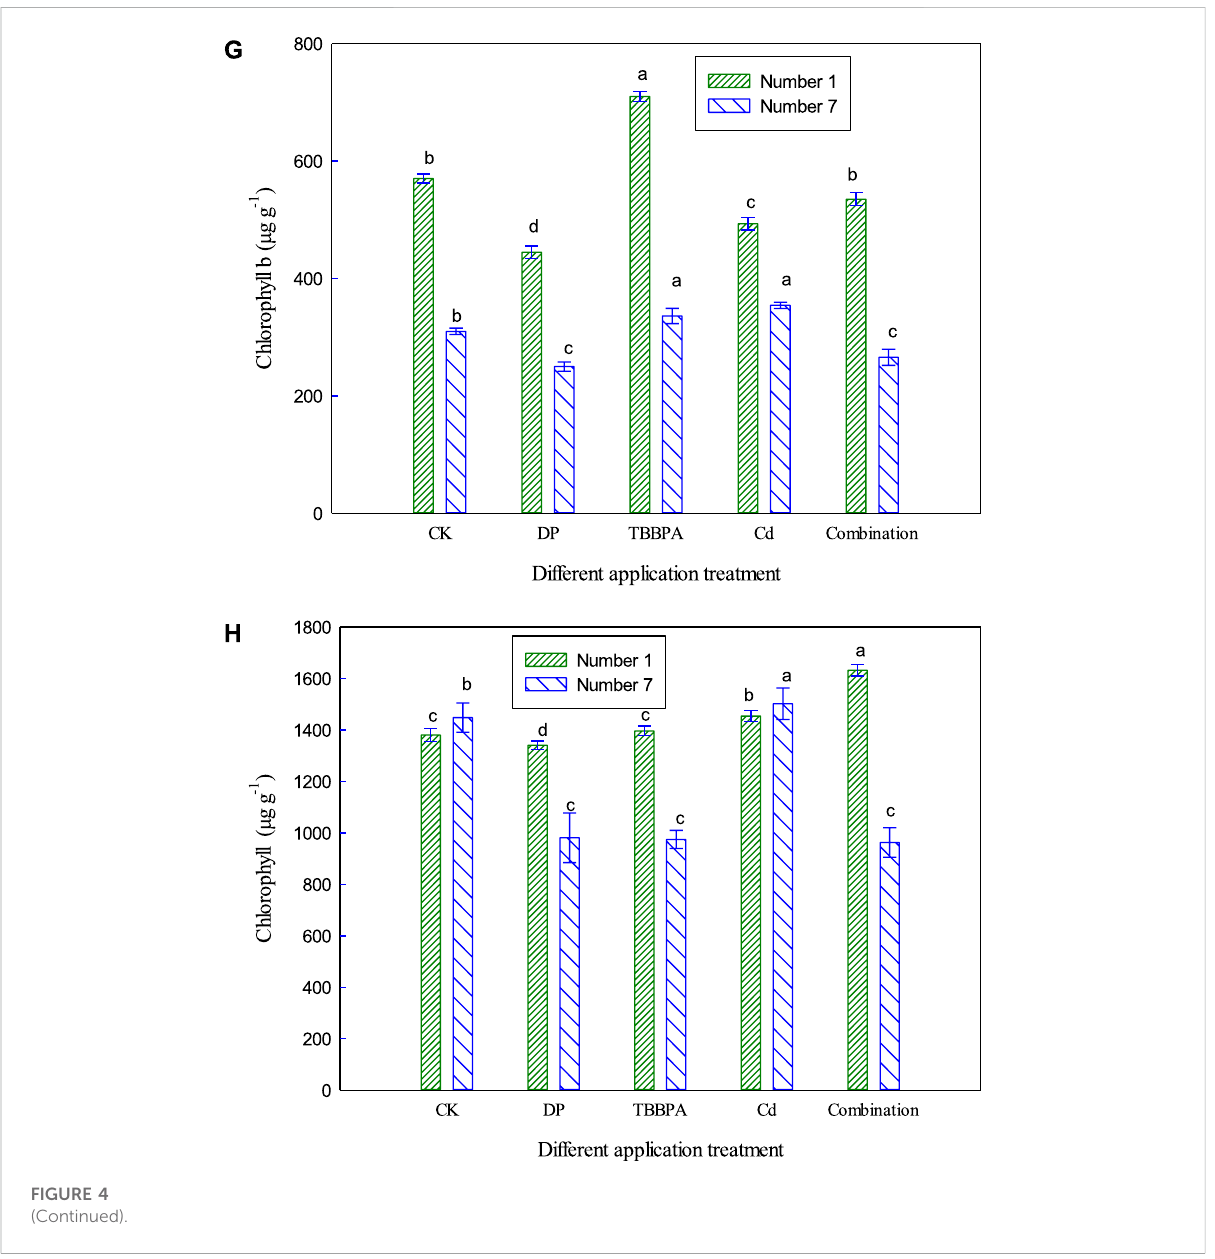
Table 2. Bioaccumulation factors of syn-DP and anti-DP